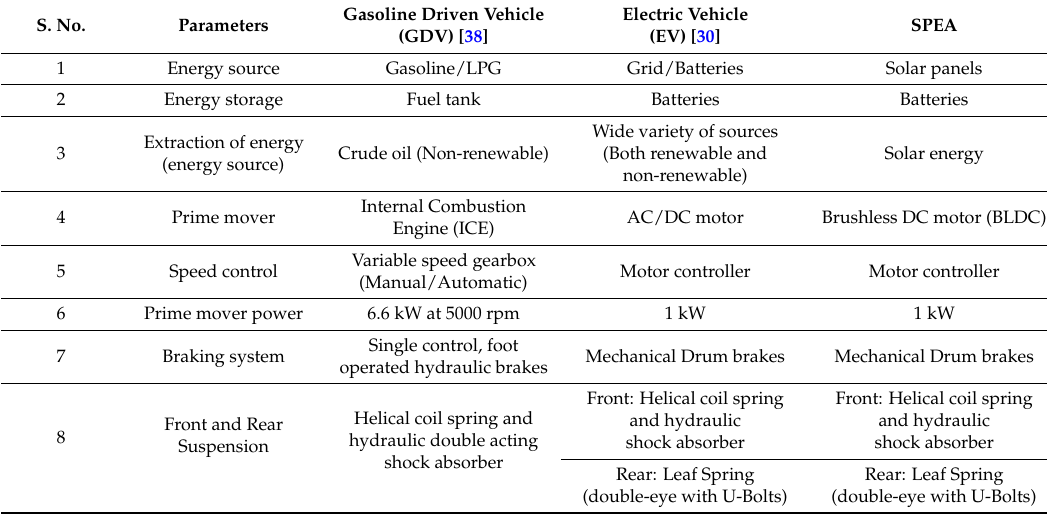
Table 4. Comparison of Vehicle features.